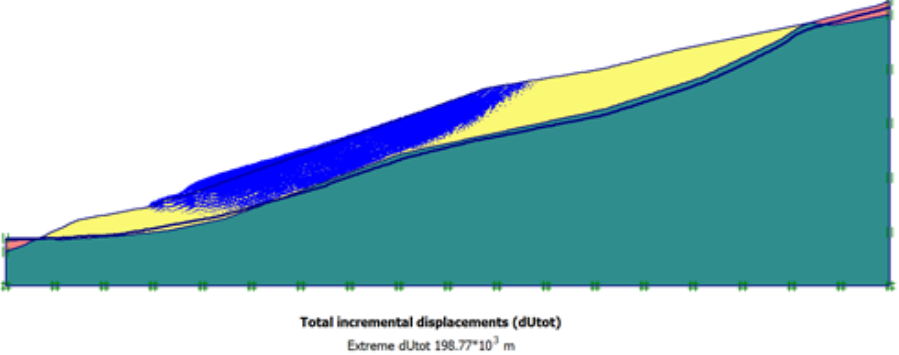
Fig. 8. Representation of the probable failure wedge using displacement vectors.